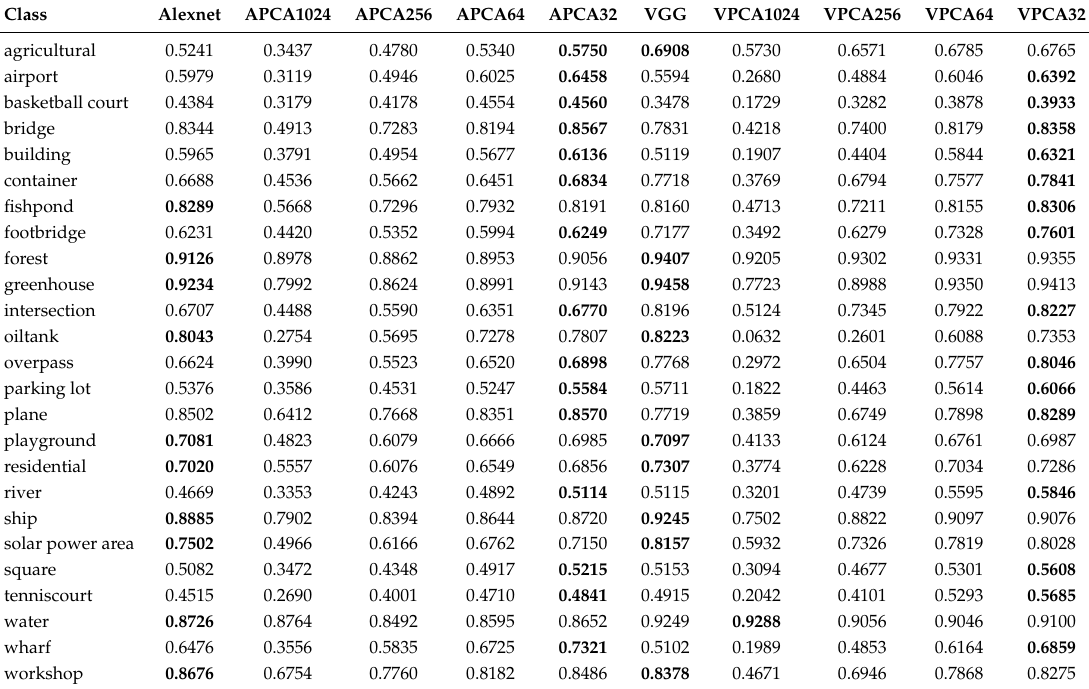
Table 9. P@100 values obtained using the DPCA